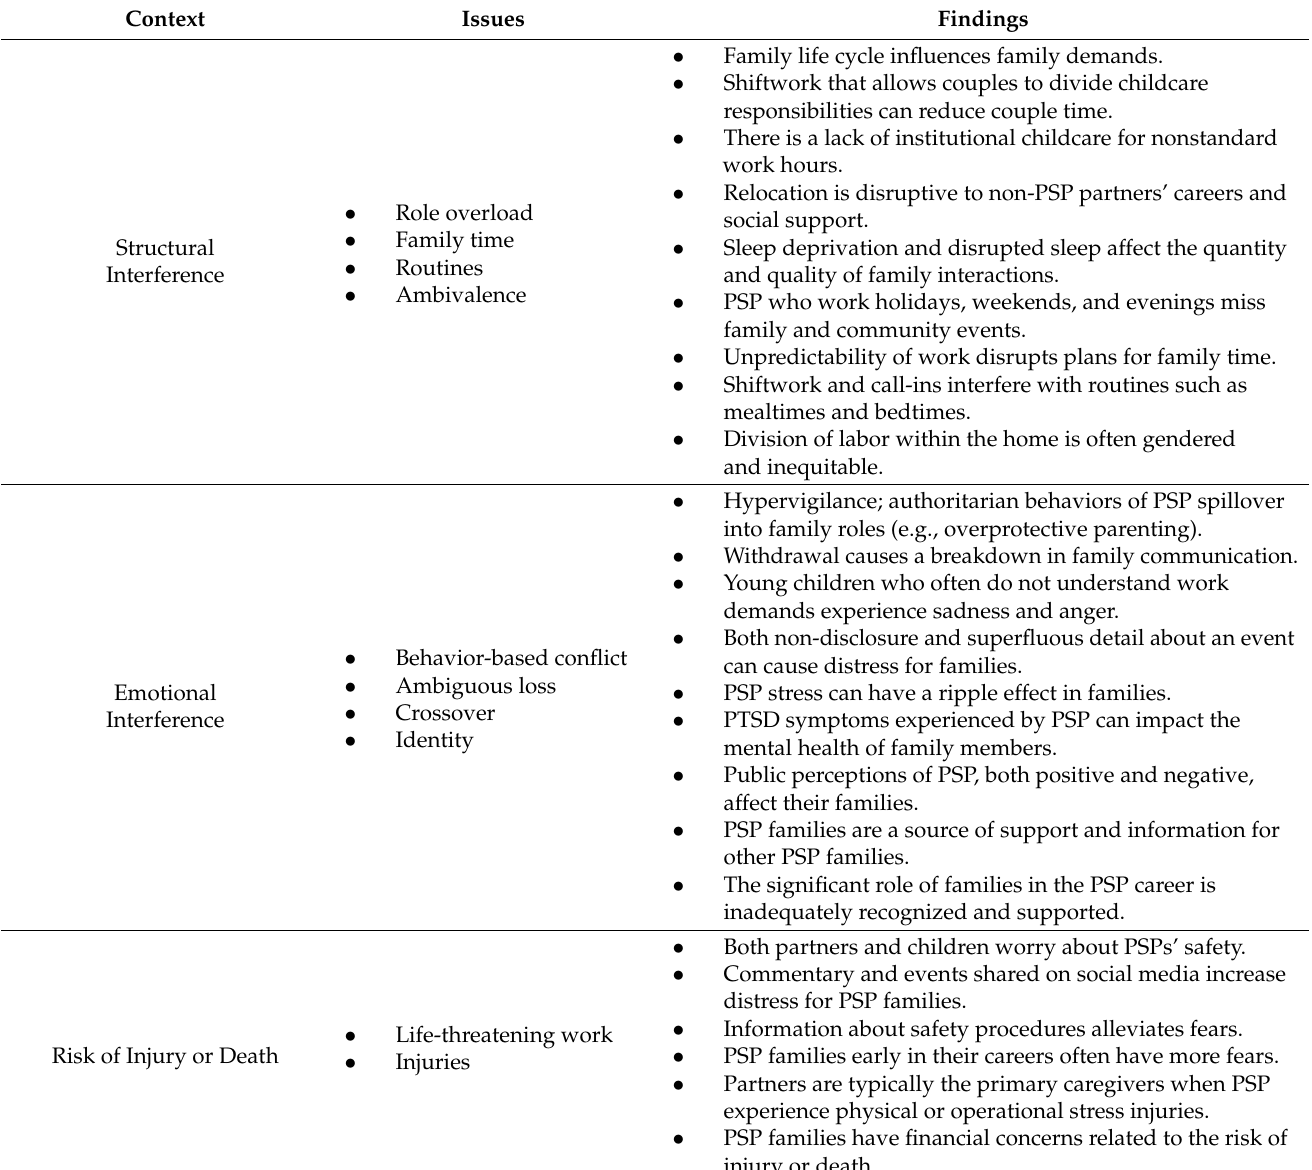
Table 2. Summary of